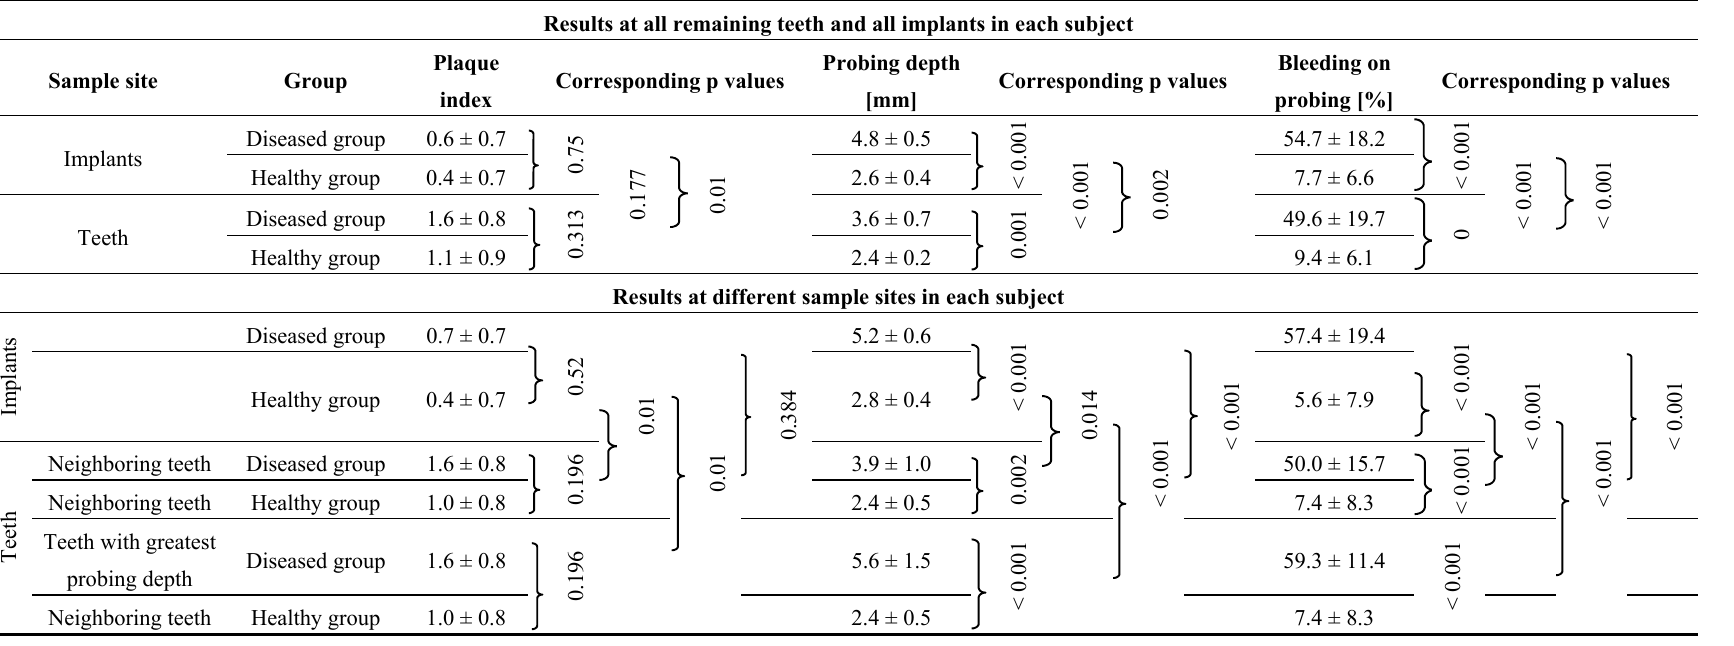
Table 1. Comparison of plaque index, probing depth and bleeding on probing between the healthy and diseased group and corresponding p values. Results at all remaining teeth and all implants in each subject Plaque Probing depth Bleeding on Sample site Group Corresponding p values Corresponding p values Corresponding p values index Diseased group Implants